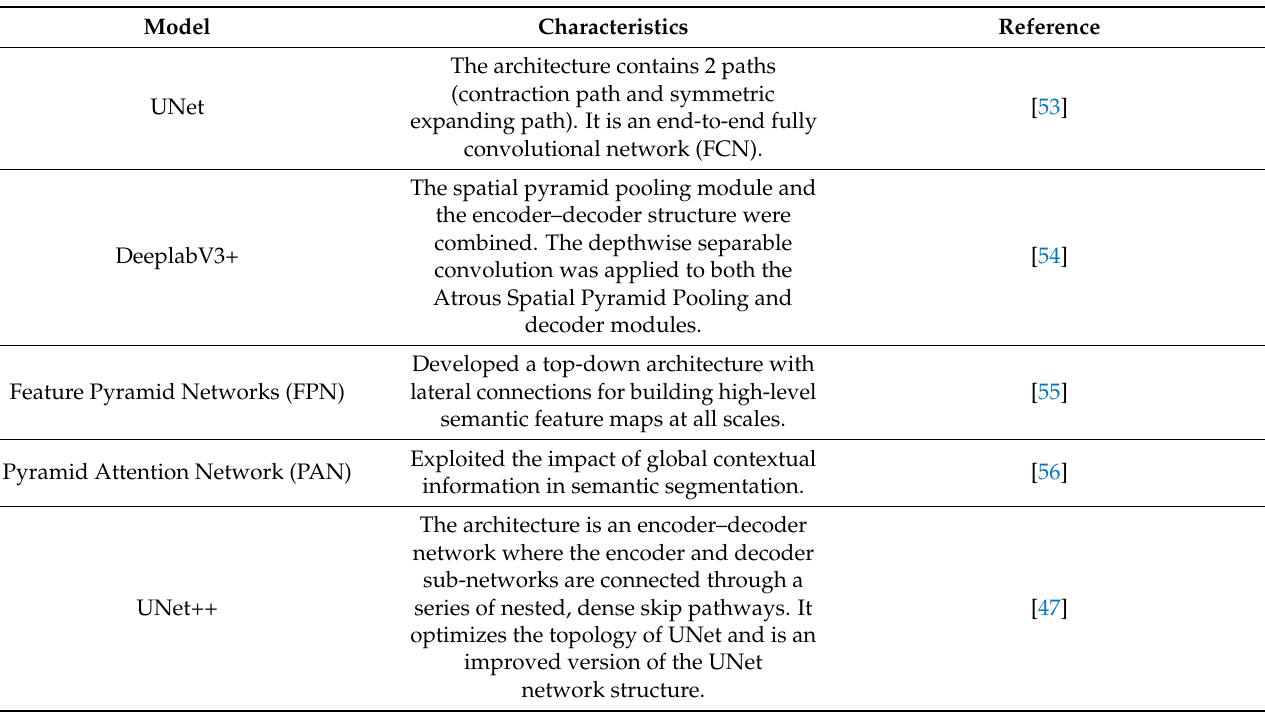
Table 3. Other common semantic segmentation models and their